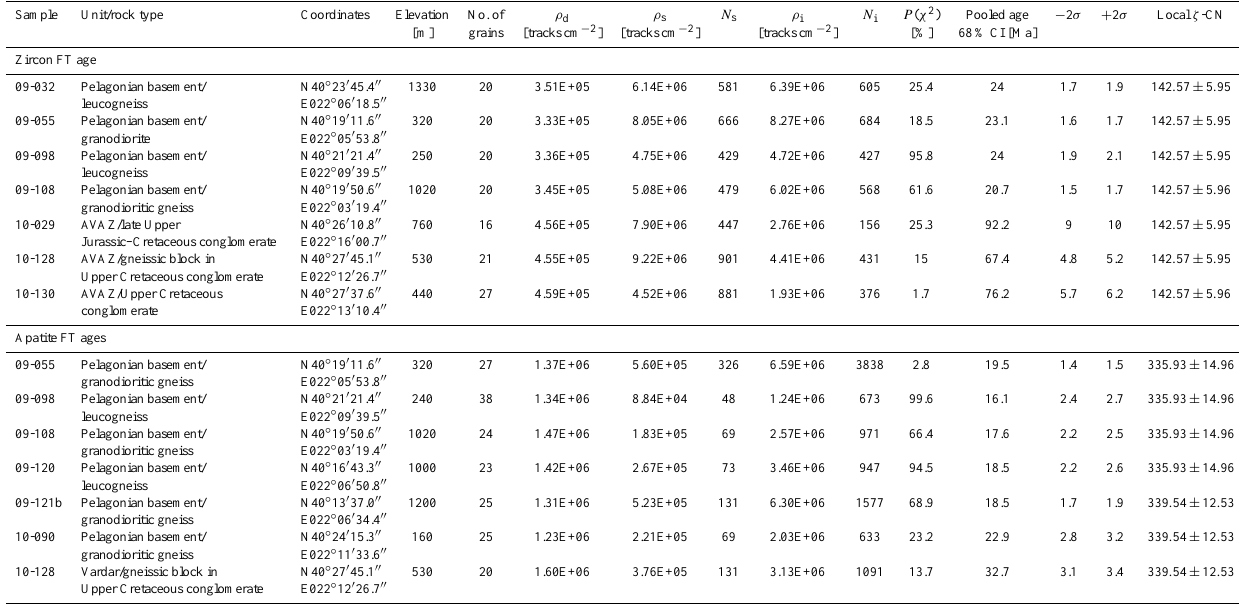
Table 1. Pooled ages calculated using dosimeter glass CN5 and CN1 for zircons and apatites, respectively. ρ s is the spontaneous track densities measured in internal mineral surfaces; N s is the total number of spontaneous tracks; ρ i and ρ d are the induced and dosimenter track densities on external mica detectors; N i and N d are the total numbers of tracks; P ( χ 2 ) is the probability of obtaining χ 2 value for y degrees of freedom (where y = number of crystals − 1).